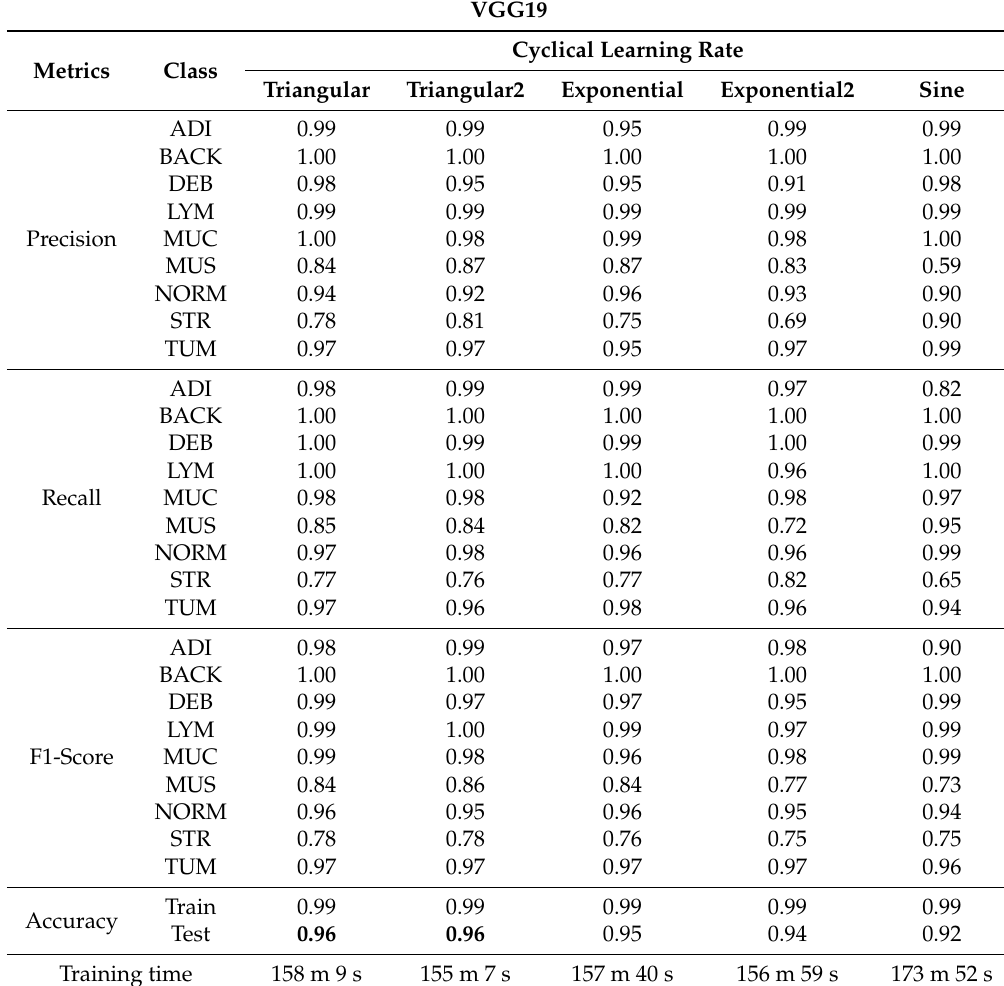
Table 3. The impact of using different methods of cyclical variation of the LR with respect to epochs on the training and validation of our model. VGG19 Cyclical Learning Rate Metrics Class Triangular Triangular2 Exponential Exponential2